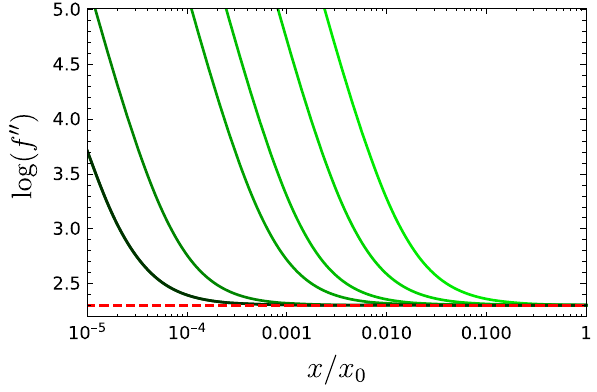
Fig. 9 Log ( f (cid:10)(cid:10) ) as a function of x / x 0 for P = 1 / 2 and fixed value of ξ = 10. Comparison between the numerical solutions from the shoot- 2 ing from the minimum (solid lines) and the analytic ones (dashed lines) fordifferentvaluesoftheYukawacoupling: h 2 ∈ { 10 − 8 , 10 − 7 , 10 − 6 , 3 · 10 − 5 , 10 − 4 , 6 · 10 − 4 , 3 · 10 − 3 } fromthedarker(left)tothelighter(right) curve